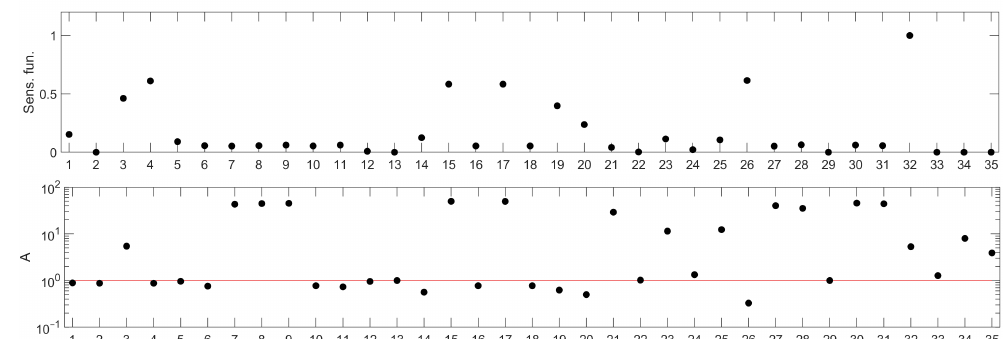
Figure 2. Parameter rankings for the p53 model: based on sensitivity functions ( upper panel ) and based on the method proposed in this paper ( lower panel ). The horizontal ( X ) axis represents the consecutive model parameters, whose names have been replaced by numbers for better readability. The parameter annotation associated with these numbers is given in Table 1. The red line in the lower panel corresponds to the A index value representing no influence of parameter change on the model response. Points located above this line represent parameters whose change (as described in the algorithm details) amplify the model response, while those below represent the parameters whose change lead to suppression of the model response. Table 1. List of parameters appearing in the p53 signaling pathway model